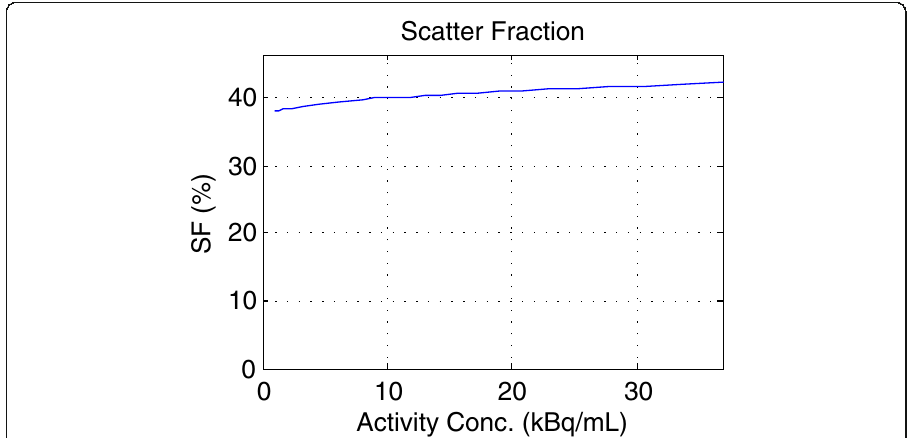
Fig. 3 Scatter fraction as a function of activity concentration. Scatter fraction at peak NECR was 41.2% on the Discovery MI 3-ring